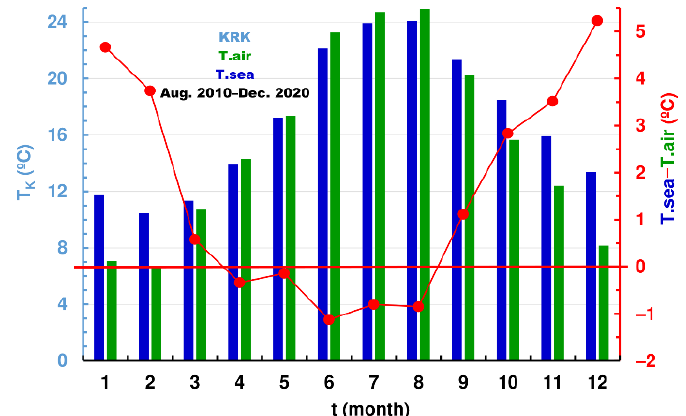
Figure 13. Histograms of the average values of the mean monthly sea surface temperatures (blue colour) and air temperature (green) and their differences (red) observed at Krk from July 2010 to